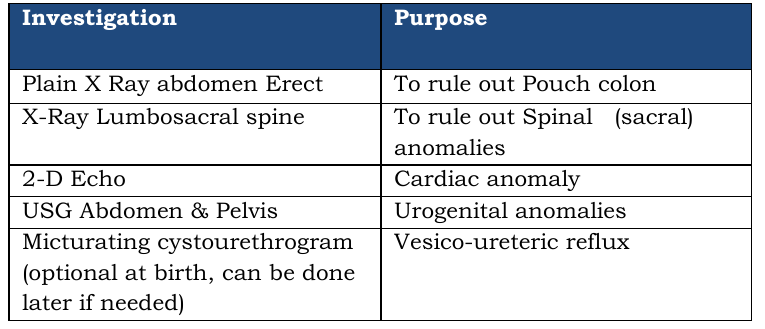
Table 3: Investigations for associated anomalies